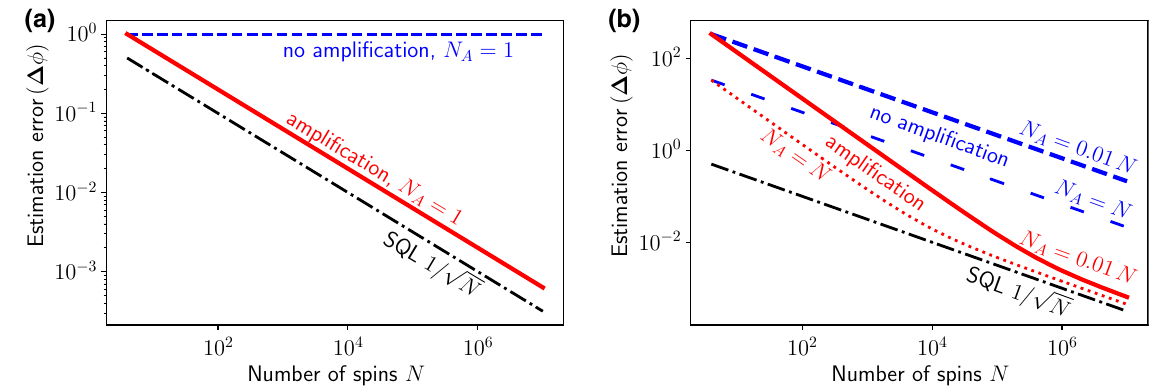
FIG. 4. The estimation error ( (cid:2) φ) if only a subensemble of size N A < N is read out after the amplification step [see Eq. (20)]. The √ superradiant decay dynamics involve all N spins; therefore, the gain factor still scales ∝ N . (a) As a consequence, even if only a √ N . Here, single spin is measured, N A = 1, amplification allows us to reduce the estimation error with a SQL-like scaling ( (cid:2) φ) ∝ 1 / = 0; adding detection noise will only change a constant prefactor that shifts the dashed blue and solid we consider the ideal case (cid:13) 2 det red curves vertically relative to the dash-dotted SQL curve. (b) A comparison between a measurement of the full ensemble, N A = N , and a measurement of only a small subensemble, N A = 0.01 N , in the presence of detection noise, (cid:13) det = 67. For the subensemble, the initial estimation error is higher due to the smaller number of measured spins but the gain still allows us to reduce the readout noise with a 1 / N -like scaling until intrinsic and added noise become appreciable. The plots are based on Eq. (20), the MFT scaling relations = 1) and a worst-case estimate q = 1 [equivalent to maximum ( (cid:2) S A ) 2 fluctuations of the measured (i.e., c 0 = 1 / 2, σ 2 y add